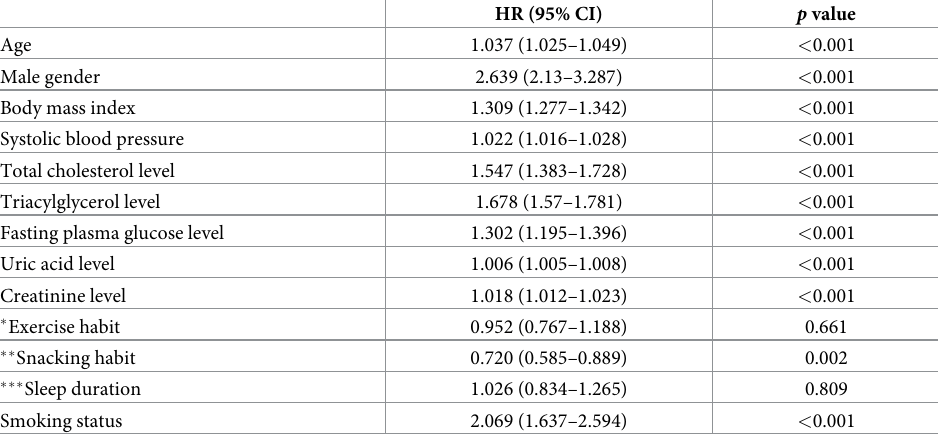
Table 4. Univariate analysis of the risk factors associated with the onset of fatty liver disease in the low alcohol consumption